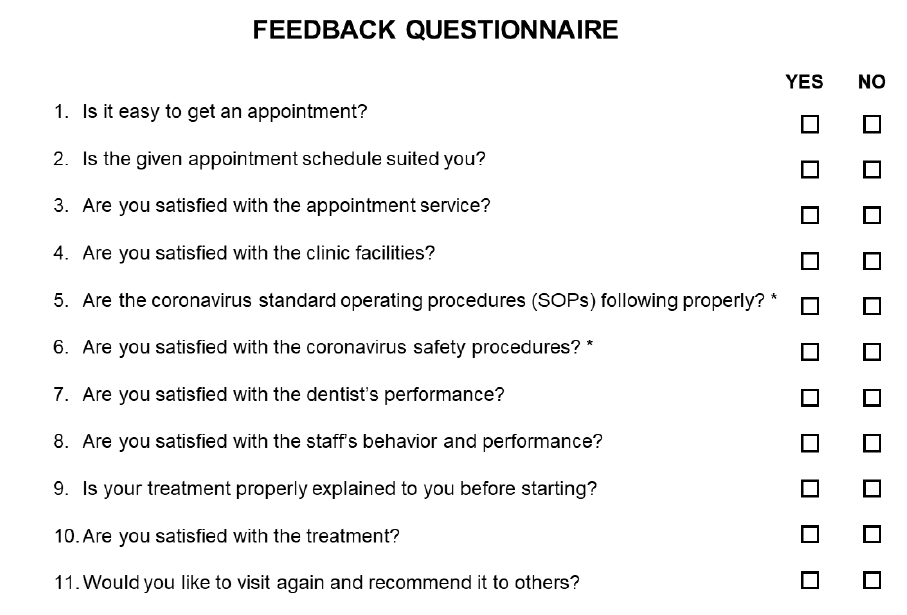
Figure 2. Feedback questionnaire ( * the question refers to groups 2 and 3).